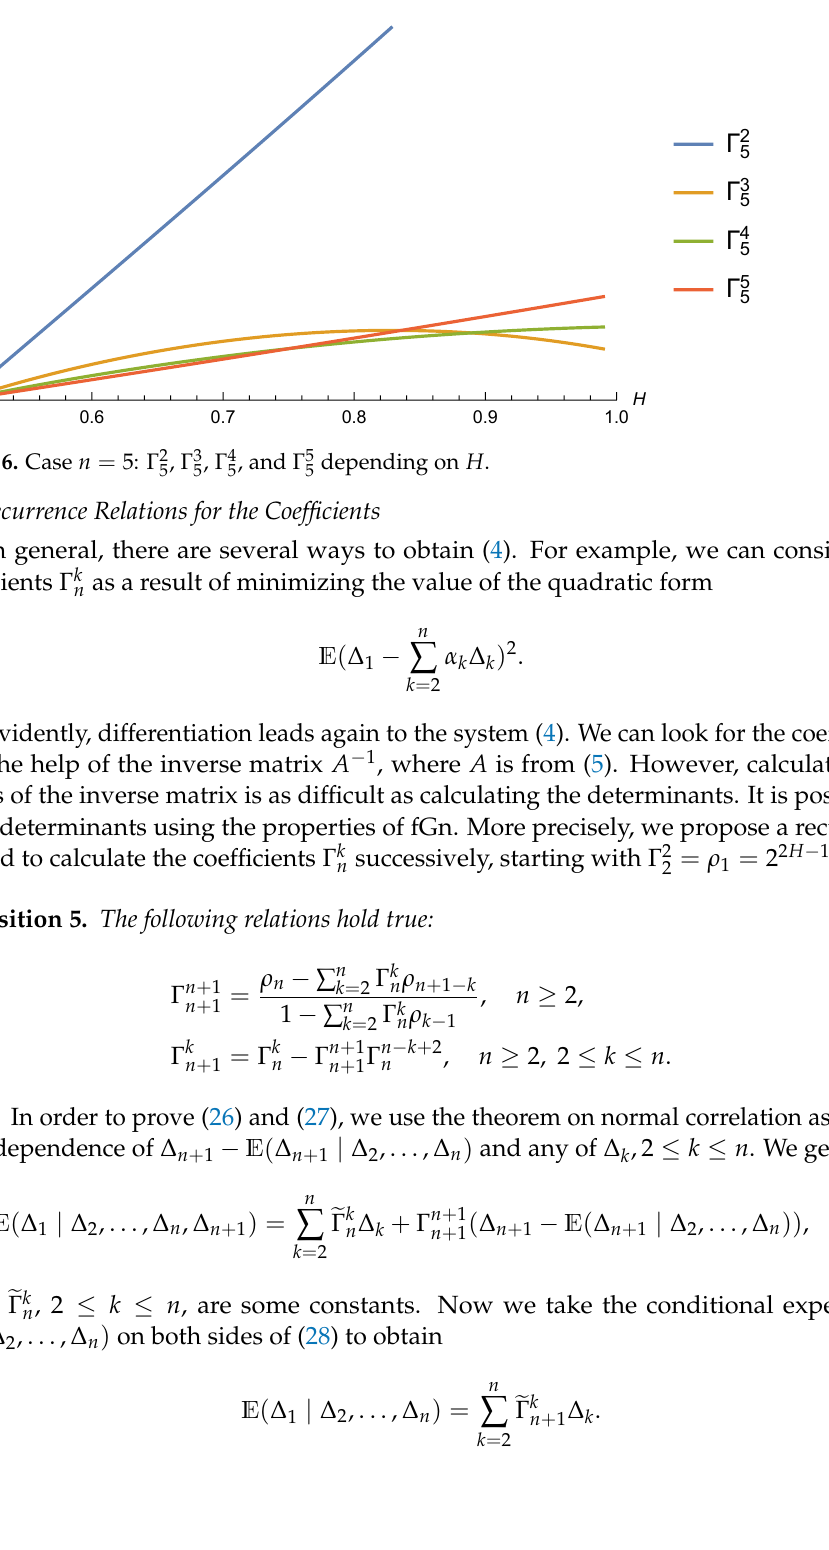
Figure 6. Case n = 5: Γ 2